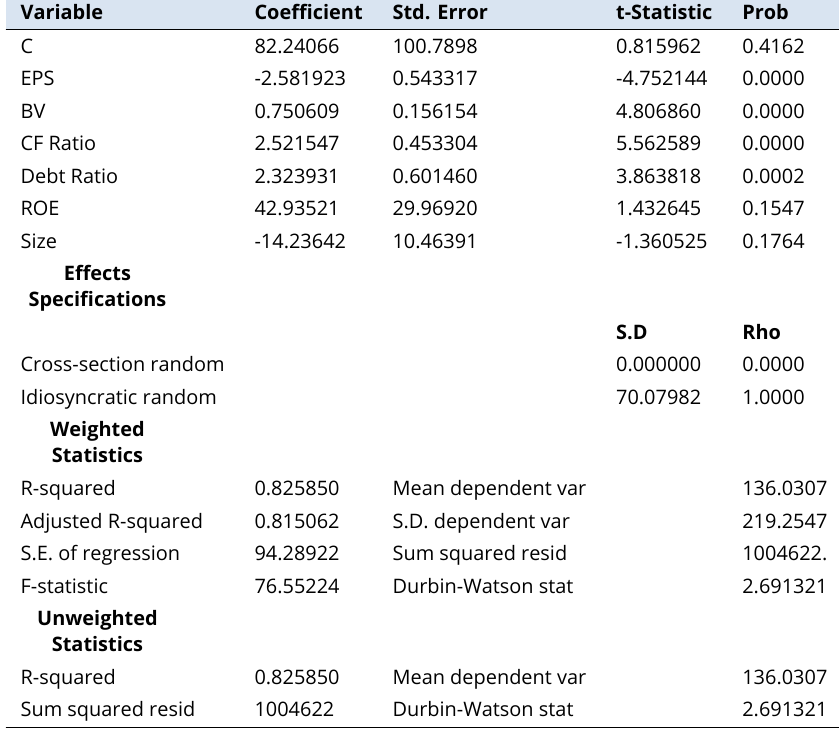
Random Effect Model of Post IFRS period –